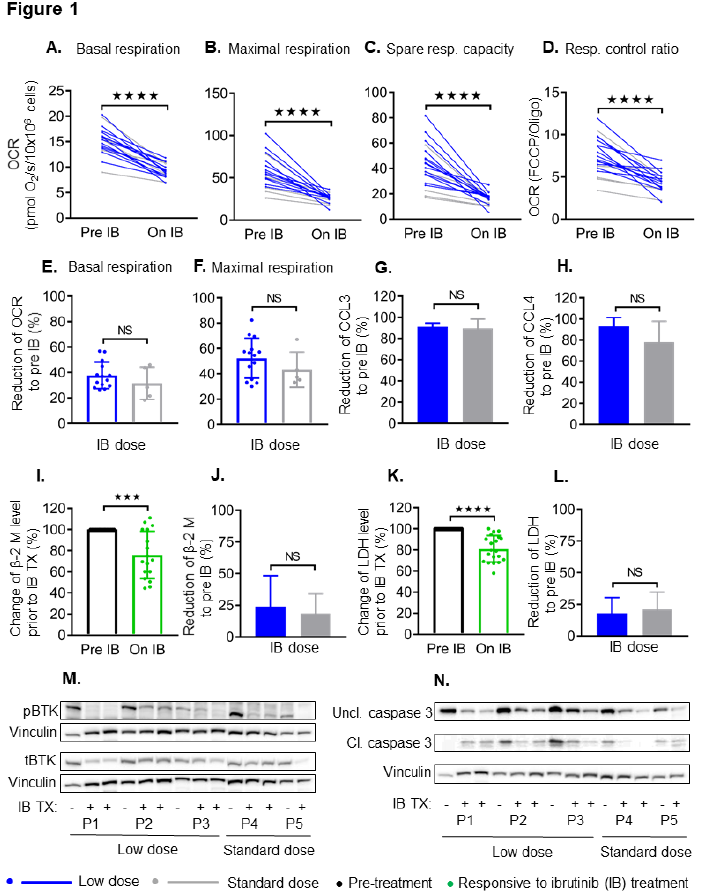
Figure 1. Ibrutinib has similar effects on mitochondrial respiration profiles, CCL3 and 4, β -2 M, lactate dehydrogenase (LDH), Bruton tyrosine kinase (BTK) signaling and caspase-3 cleavage in chronic lymphocytic leukemia (CLL) patients independent of dose. The effect of ibrutinib treatment on basal respiration ( A ), maximal respiration ( B ), spare respiratory capacity ( C ), and respiratory control ratio ( D ) in primary CLL cells from patients pre-treatment and on ibrutinib treatment with low (blue) or standard (grey) dose. N = 14 for low dose and N = 5 for standard dose of ibrutinib. Values are mean ± S.D. **** p < 0.0001 (paired two-tailed Student’s t -test). The reduction of mitochondrial respiration parameters with low and standard dose of ibrutinib treatment is summarized for basal respiration ( E ) and maximal respiration ( F ) in freshly isolated CLL cells. N = 14 for low dose and N = 5 for standard dose of ibrutinib. Values are mean ± S.D. *** p < 0.0005, NS: non-significant (unpaired two-tailed Student’s t -test). In parallel, there is a reduction of chemokine ligands CCL3 ( G ) and CCL4 ( H ) in ibrutinib treated CLL patient plasma samples by dose. Decreased levels of β -2 M and LDH in ibrutinib treated patients compared to pre-treatment ( I , K ) and the decrease of β -2 M or LDH was similar to low or standard dose ibrutinib CLL patients ( J , L ). Demonstration of effects on pBTK, tBTK ( M ), and caspase-3 cleavage ( N ) are independent of dose. OCR: Oxygen consumption rate; resp: Respiratory; IB: Ibrutinib; TX: Treatment; Uncl. caspase-3: Uncleaved caspase-3;